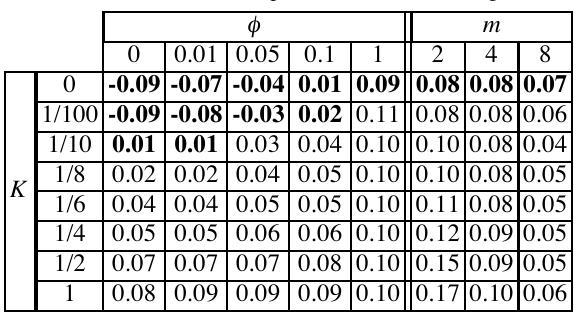
Table 7. Influence of the update method in the SD game.